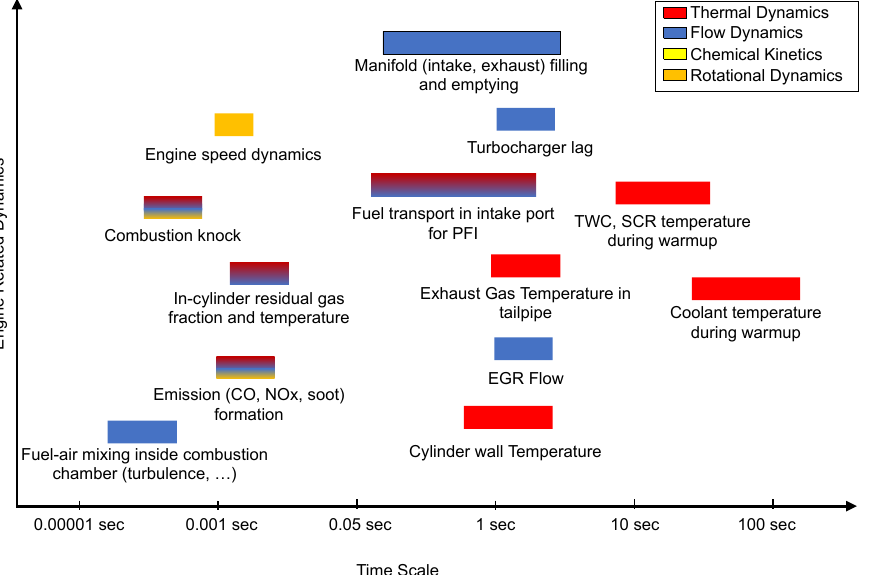
Figure 8. Time scale of engine related dynamics for a light-duty engine running between 1000 and 4000